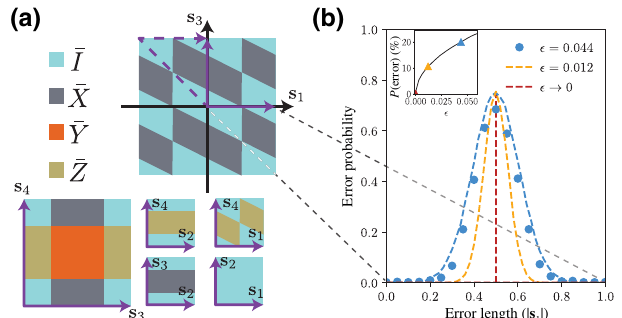
FIG. 11. Effect of translation errors in the D 4 code. (a) Logical operation applied (colors) as a function of the initial translation error in the planes given by span( s j , s k ). One could achieve the isthmus property by performing controlled translations follow- ing the purple dashed line instead of the more direct full line in the { s 1 , s 3 } panel. (b) Logical error probability as a function of the length of a translation error along s 1 . We compare the full quantum model (blue dots) and the classical model (dashed lines) Inset: integrated logical error probability given that an error η s 1 occurred, with η sampled